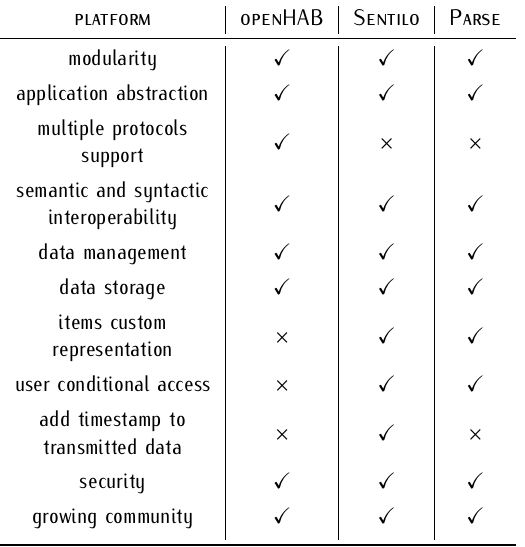
Table 3. Comparison among the platforms platform openHAB Sentilo